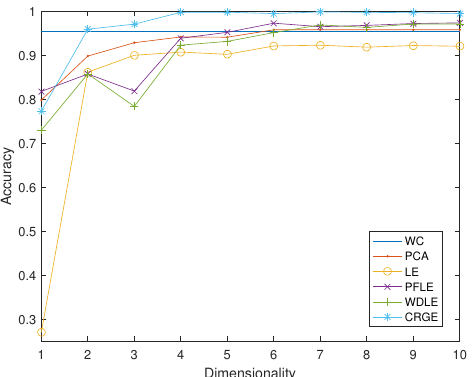
Figure 6. Classification accuracies of six methods with varying dimensionality ranging from 1 to 10 on the subset of the Flevoland data set.